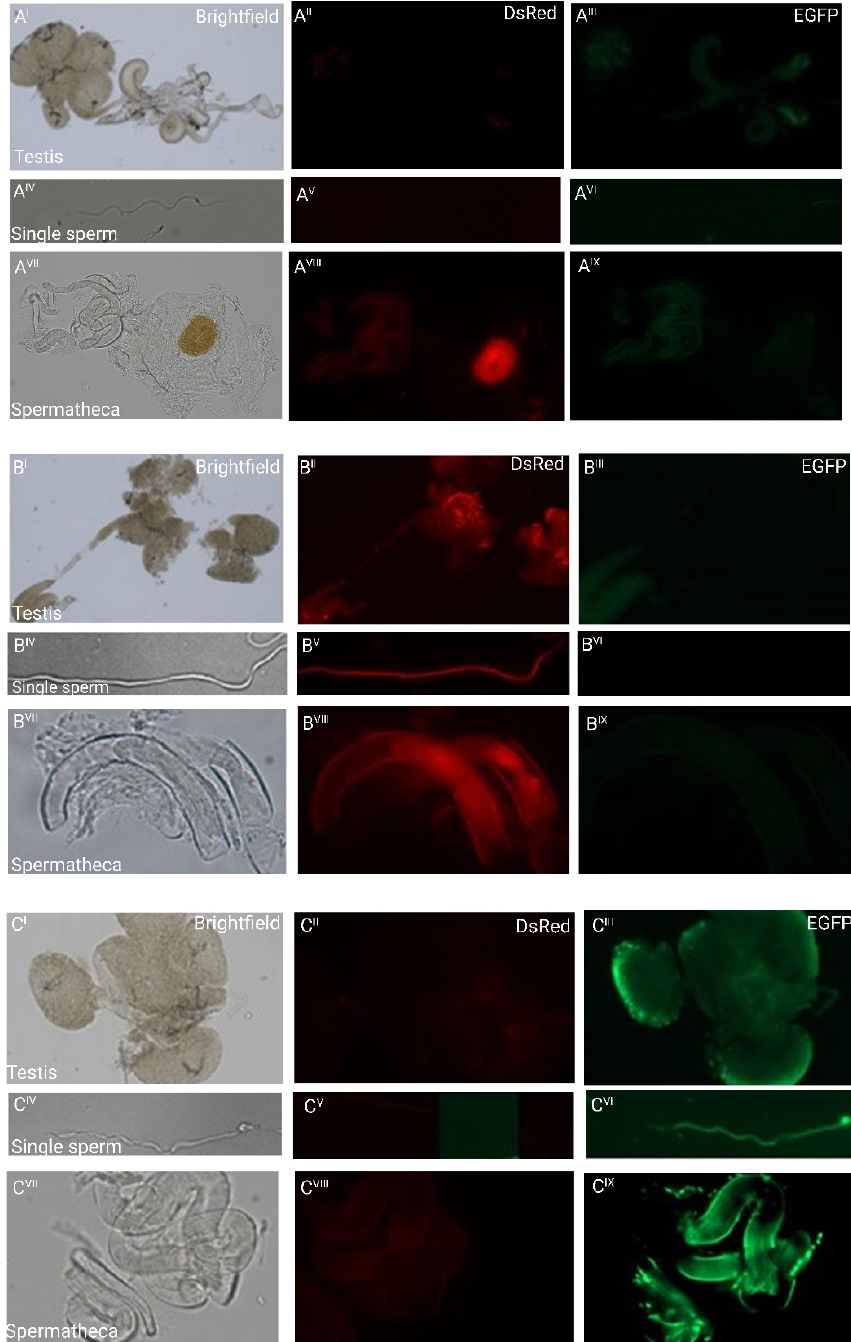
Figure 2. Fluorescent sperm detection in dissected testes (I–III), as individual sperm (IV–VI), and spermathecae (VII–IX) of non ‐ transgenic females inseminated by transgenic males: ( A ) weak green autofluorescence in the testes of non ‐ transgenic males and red autofluorescence of the chitinous O ‐ ring structure to the right of the spermathecal tubules of a non ‐ transgenic female inseminated by a non ‐ transgenic male. No other fluorescence patterns are observed; ( B ) the testes and single sperm from a transgenic male carrying pBac{3xP3_EGFP_SV40af _ attP _ β 2t _DsRed_SV40af} and the sper ‐ mathecal tubules of a non ‐ transgenic female mated to such a male show strong red fluorescence only; ( C ) the testes and single sperm from a transgenic male carrying pBac{3xP3_DsRed_SV40af _attP_ β 2t _EGFP_SV40af} and the spermathecal tubules of a non ‐ transgenic female mated to such a male show strong green fluorescence only.